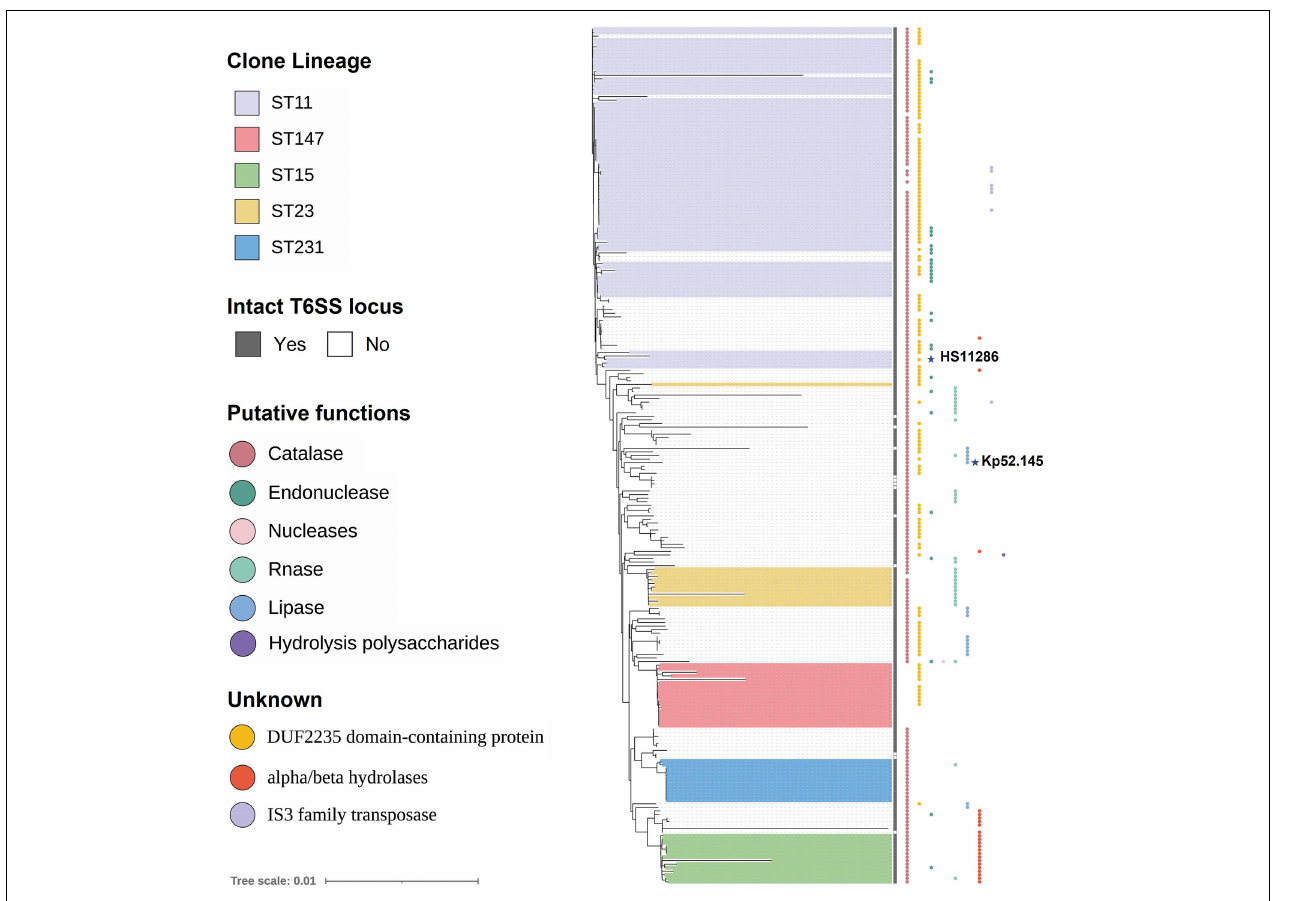
FIGURE 6 | Phylogenetic trees of 241 strains of K. pneumoniae showing T6SS effectors. Strains enclosed by the purple box are ST11 strains. Similarly, different colored boxes show strains of different ST types. The predicted effectors encoded by each strain are indicated by the colored circles at the tip of strain name, with the color of each circle representing the predicted type of each effector. Refer to Supplementary Files 1 for raw phylogenetic tree data. The labeled stars indicate the listed